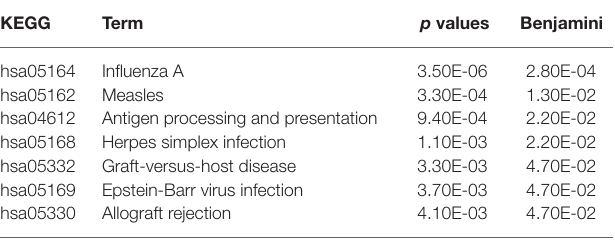
TABLE 4 | Enriched functional terms of the 50 EnRank-detected PH